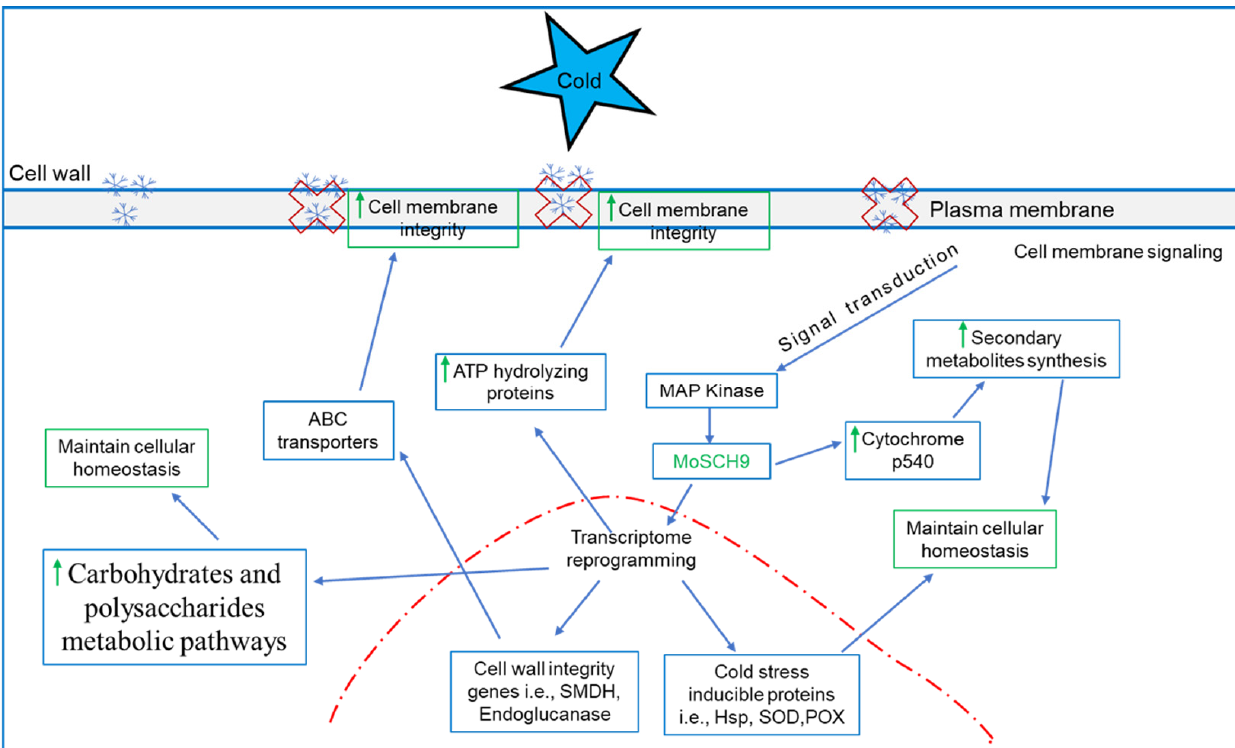
Figure 7. Hypothetical model of MoSch9 molecular mechanism during cold stress. During cold stress fungal cells use the cell wall and membrane protein signaling system to initiate MoSch9 expression in MAP kinase cascade system. which in turn initiates the gene reprogramming of ATP hydrolyzing proteins and cell wall integrity proteins to maintain cell wall and membrane integrity. In addition, MoSch9 regulates metabolic pathways, cold tolerance genes, and CYP 540 for secondary metabolite synthesis to maintain cellular homeostasis, important for the fungal survival under cold stress